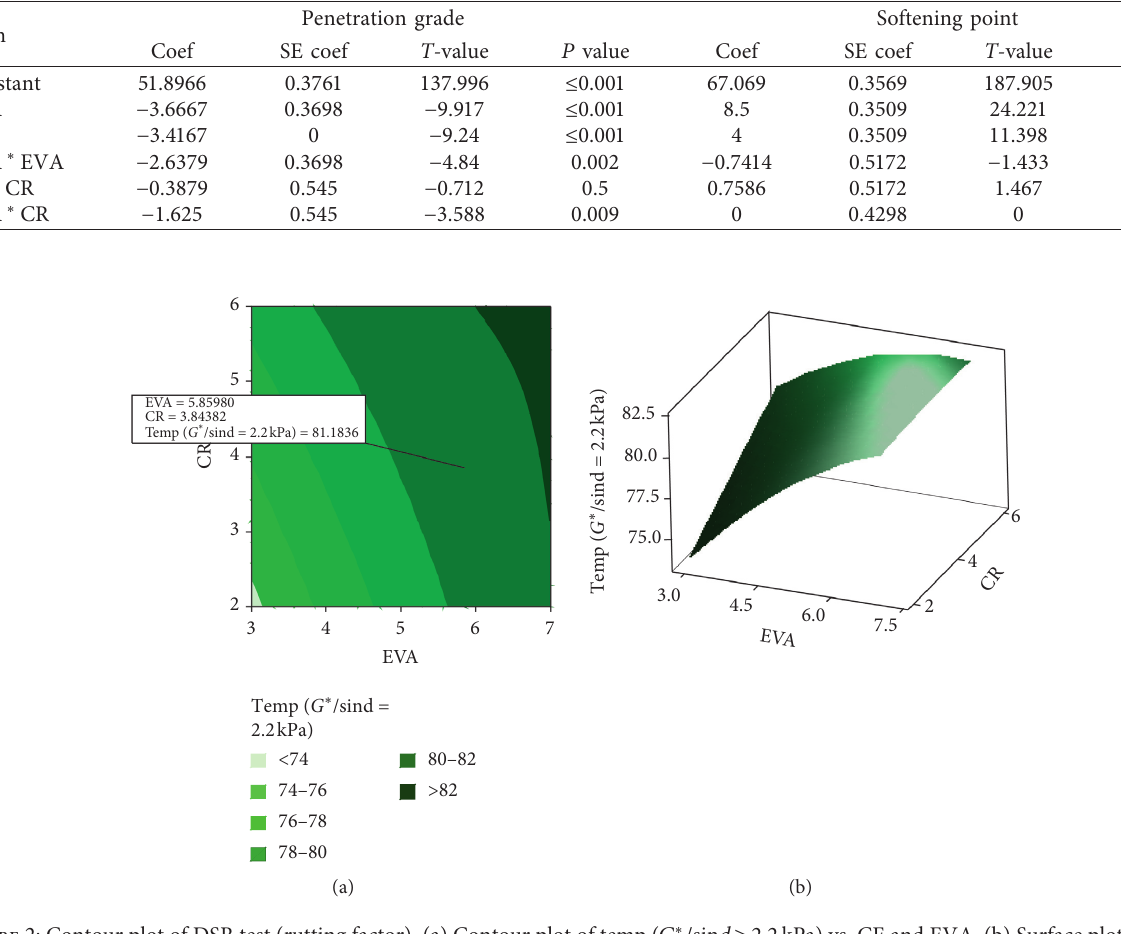
Figure 2: Contour plot of DSR test (rutting factor). (a) Contour plot of temp ( G ∗ /sin d ≥ 2.2kPa) vs. CE and EVA. (b) Surface plot of temp ( G ∗ /sin d ≥ 2.2kPa) vs. CE and EVA.